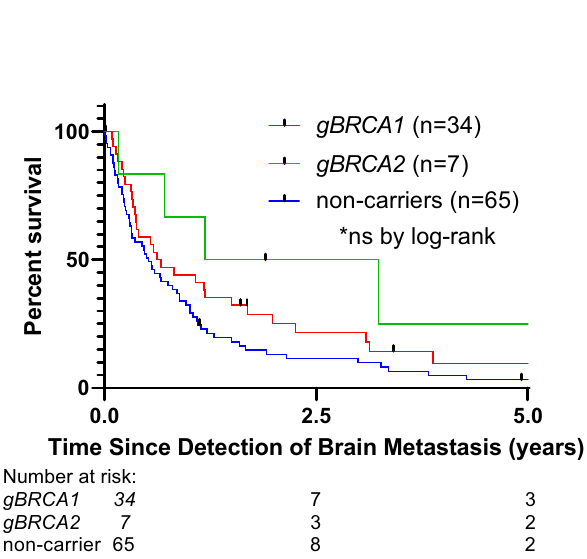
Fig. 3 Overall Survival with brain metastasis. Overall survival from the time of brain metastasis detection for breast cancer patients by gBRCA